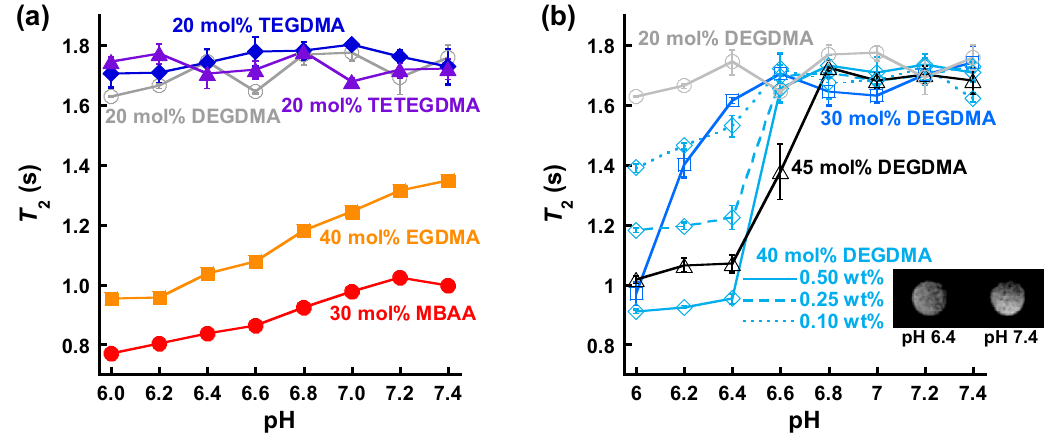
normal tissue [12].